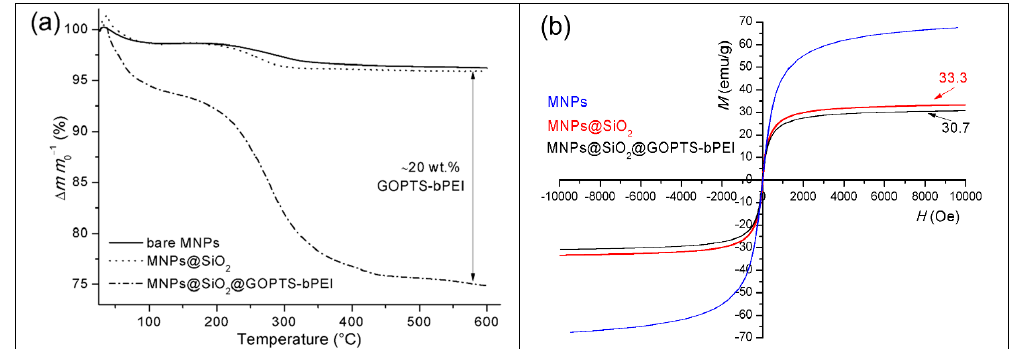
Figure 3 . TGA curves for MNPs, MNPs@SiO 2 and MNPs@SiO 2 @GOPTS-bPEI ( a ). Room-temperature hysteresis loops for bare MNPs, SiO 2 -coated MNPs and MNPs@SiO 2 @GOPTS-bPEI ( b ) .